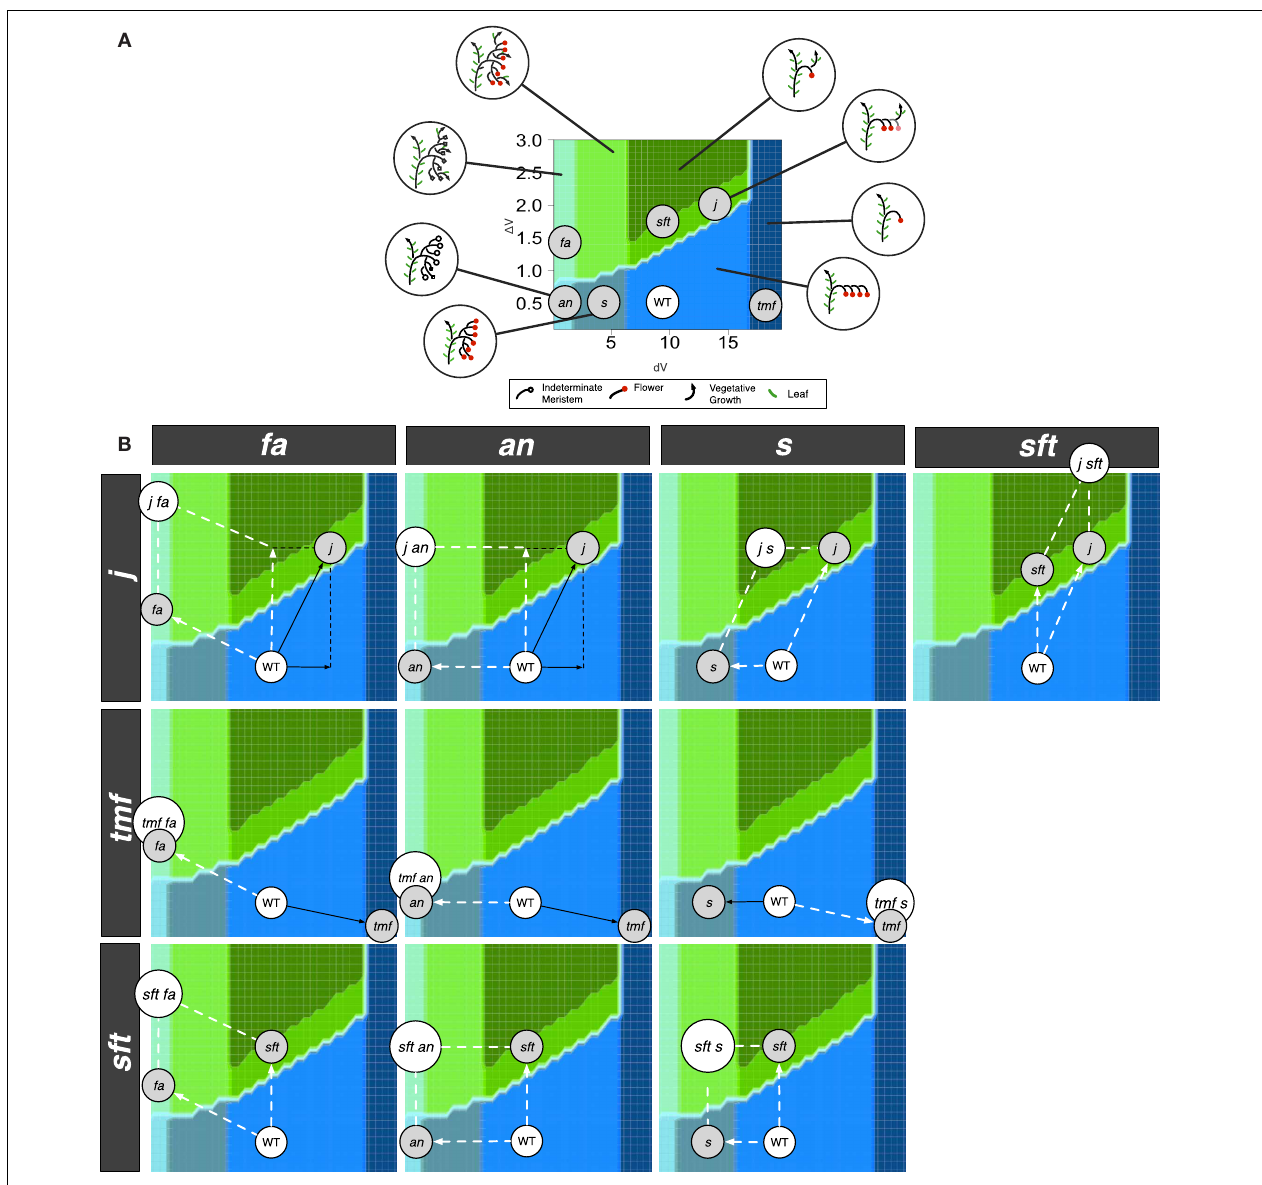
FIGURE 6 | Positioning of the single and double mutants in the morphospace. (A) Single mutants. (B) Selected double mutants. White arrows represent effective contributions (vectors) of one parent to double mutant phenotypes while black arrows show vectors masked by